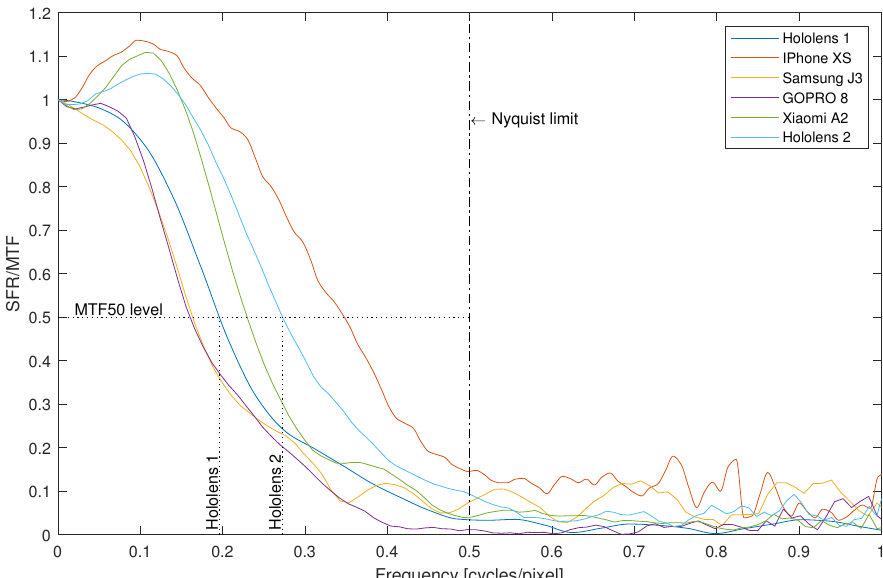
Figure 6. MTF values for exemplary devices, with depicted MTF50 values for HoloLens